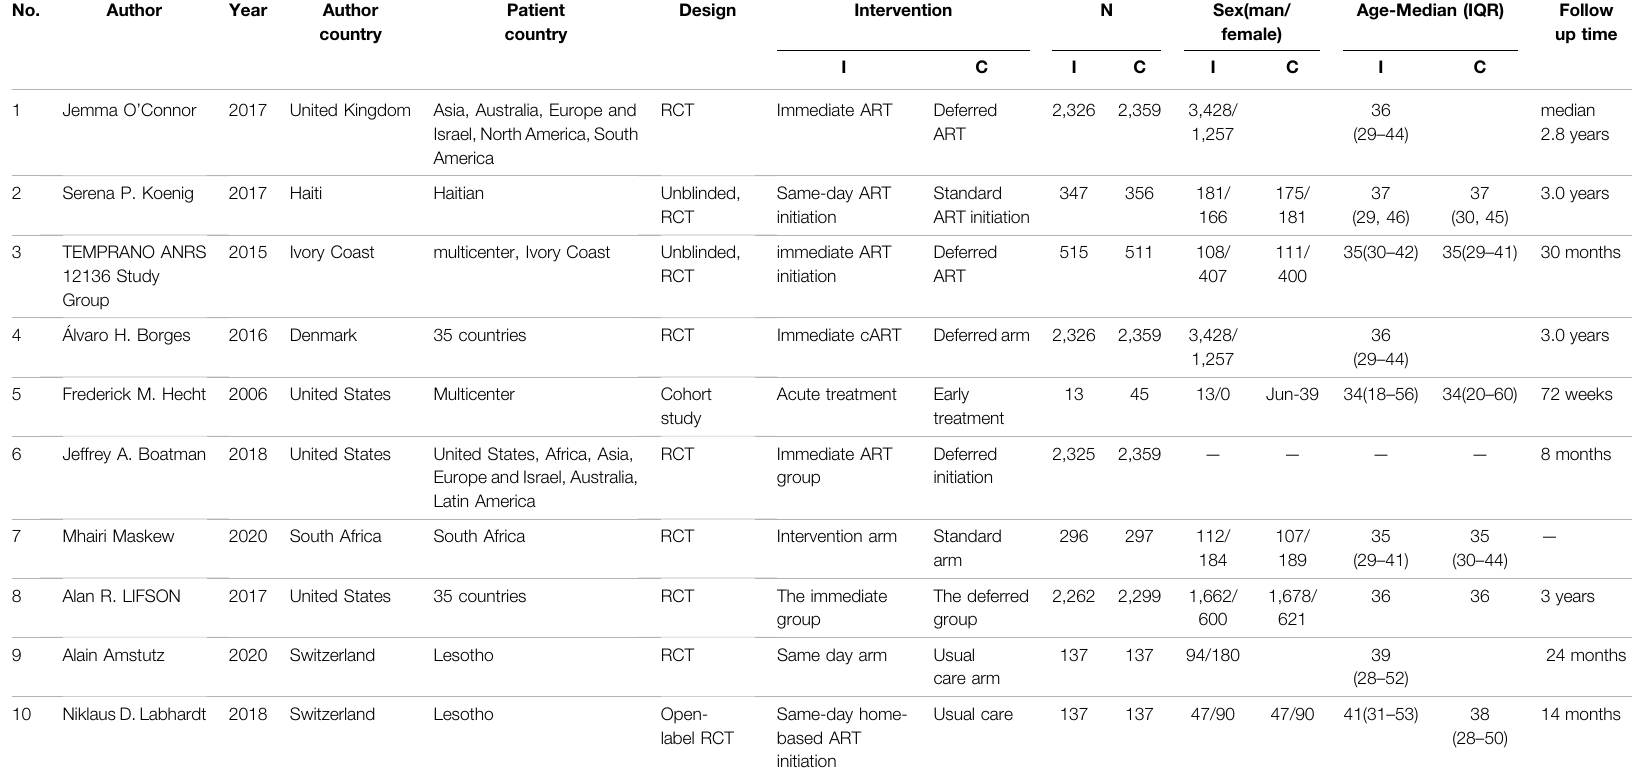
TABLE 1 | Basic characteristics of included